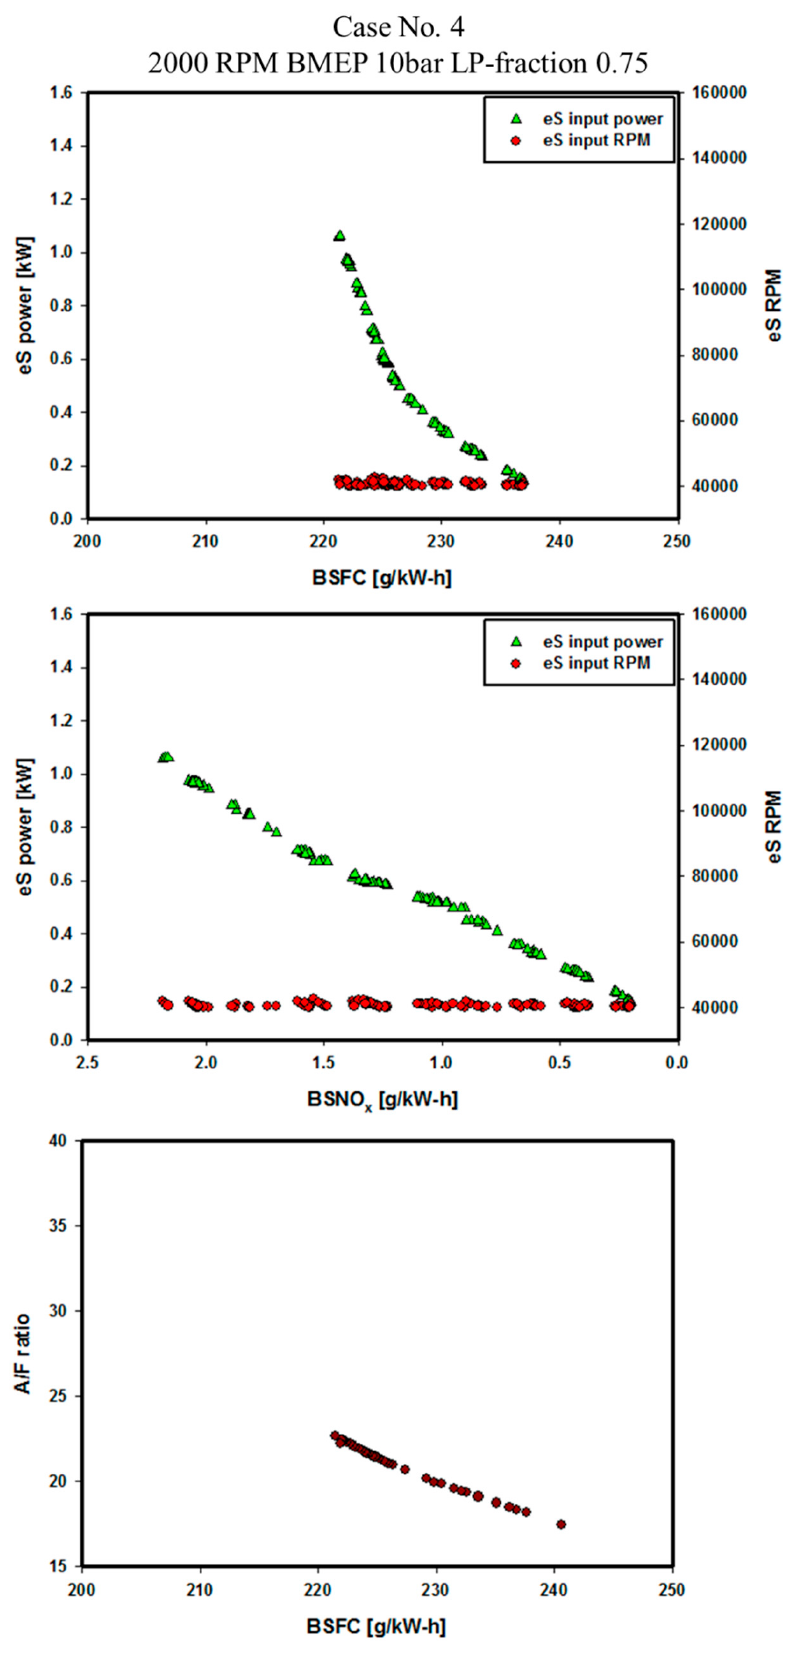
Figure 15. BSFC, BSNO x , and A/F ratio differences on the Pareto front line of case 4 (LP fraction = 0.75).